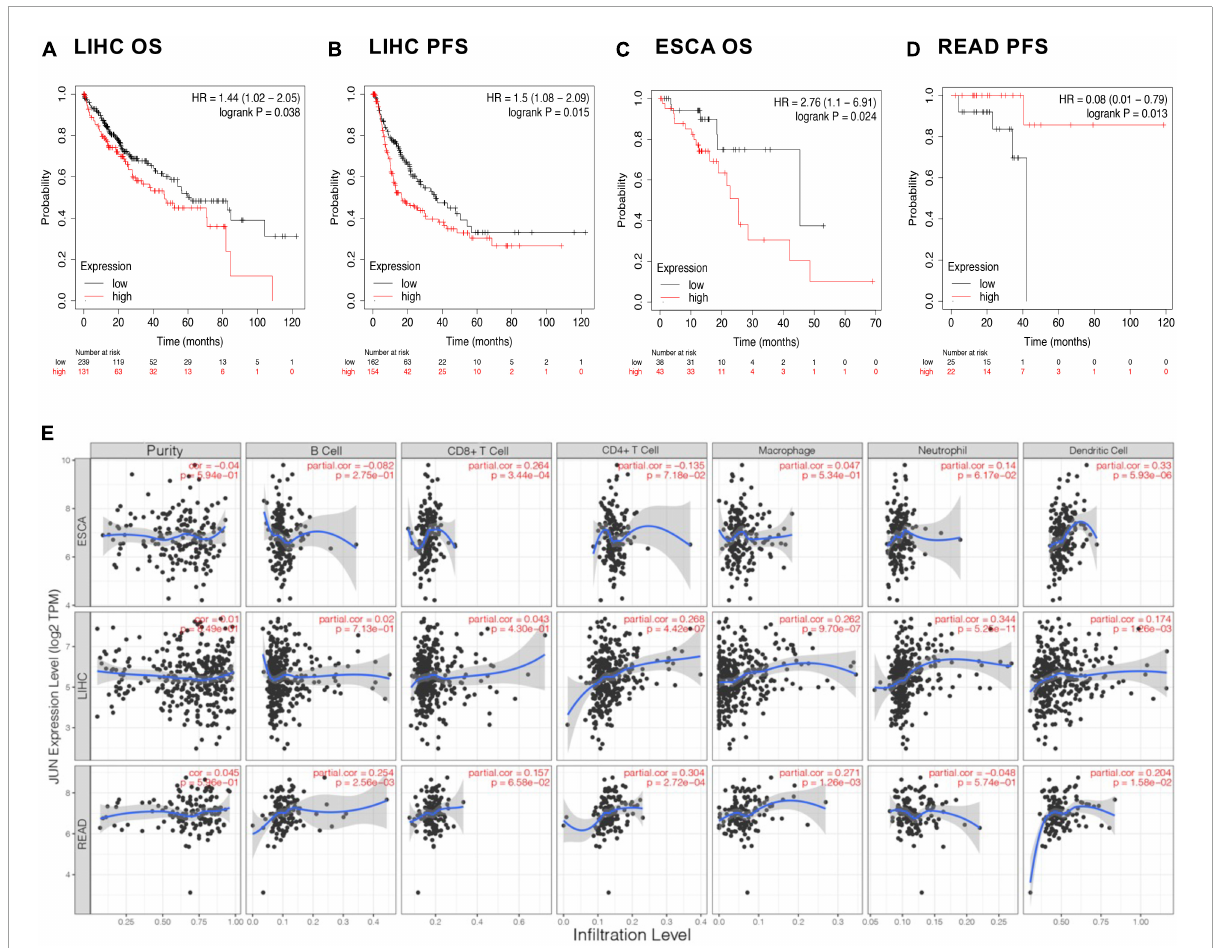
FIGURE5 Immune infiltration and prognosis. (A–D) Association of JUN with the prognosis of different cancers. (E) Correlation of JUN expression with immune